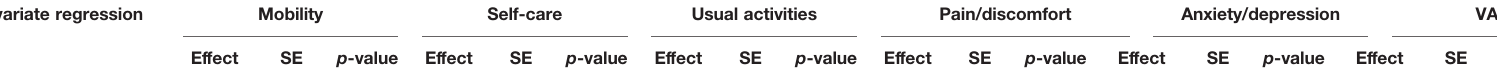
TABLE 6 | Univariate regression results for the non-progressed and progressed